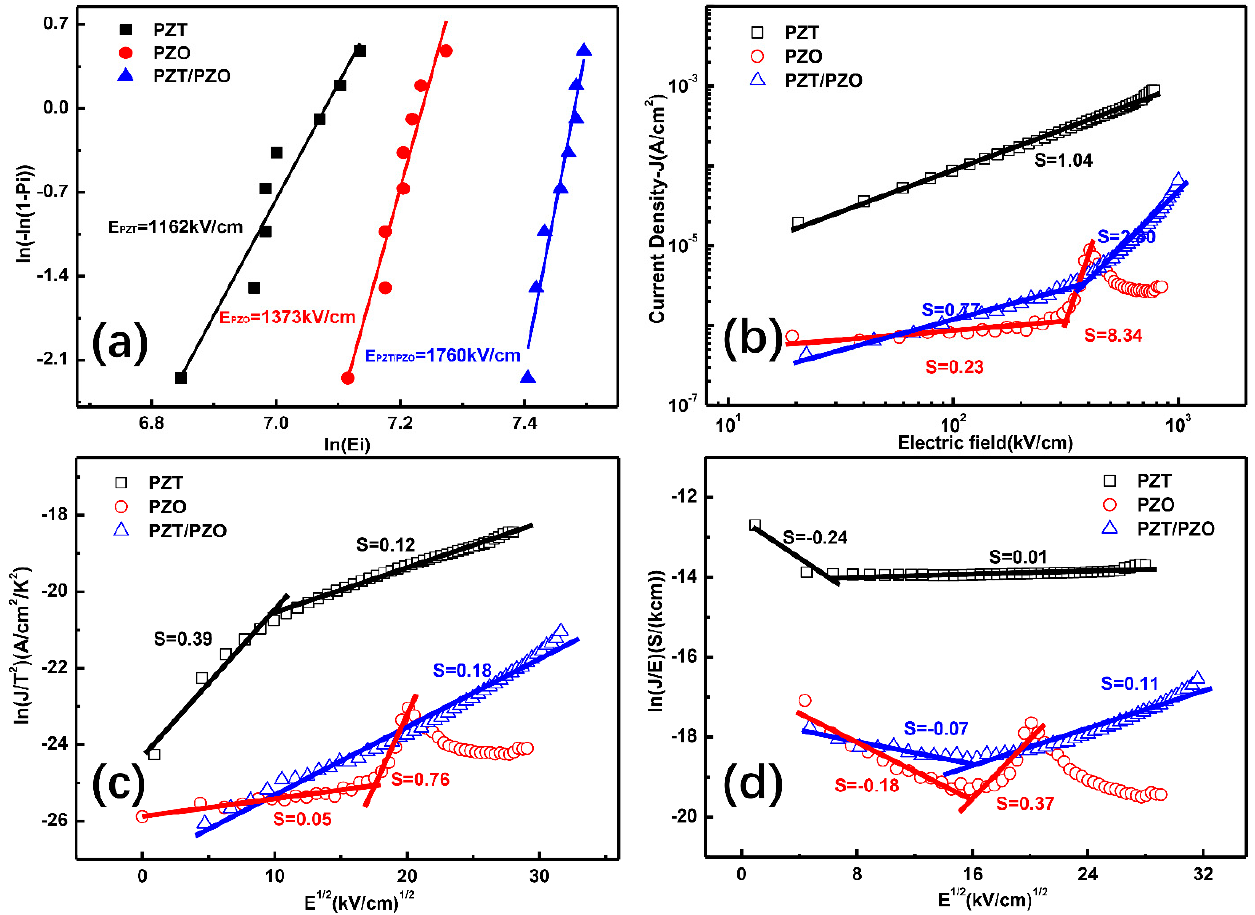
Figure 4. ( a ) Weibull plot of the breakdown electric field E BDS ; ( b ) analysis of current density behavior for PZT, PZO, and PZT/PZO multilayer films; space-charge-limited bulk conduction; ( c ) Schottky emission; ( d ) Poole-Frenkel emission.